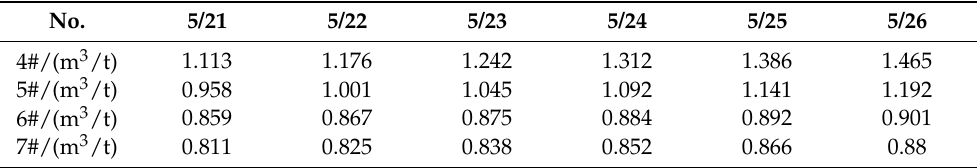
Table 3. Gas prediction data in the intake and return air roadway of working face.